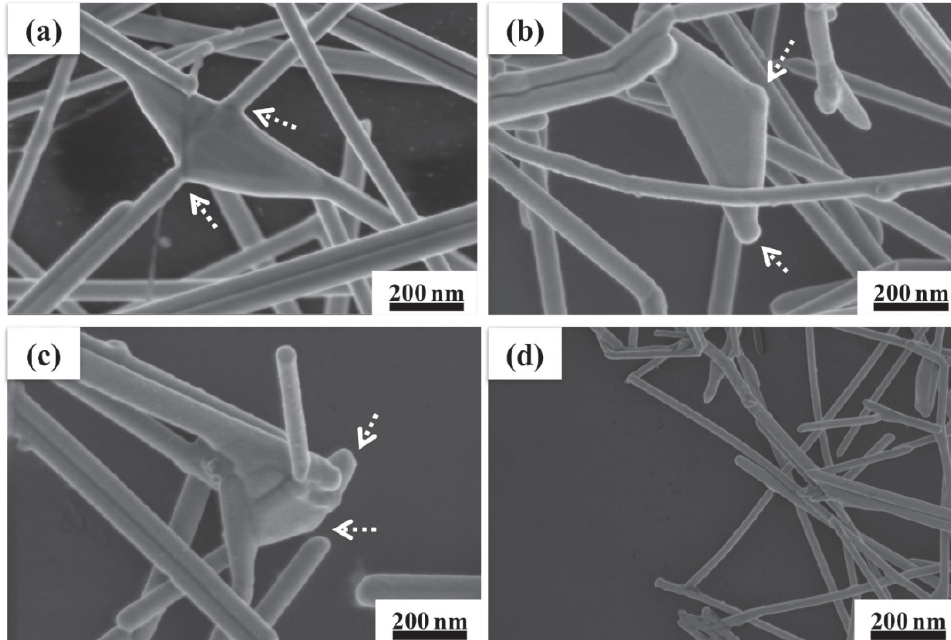
Figure 5. SEM images of annealed silver nanowire networks ( a ) before bending, ( b ) after imposing 10,000 bending cycles, and ( c , d ) after 500,000 bending cycles, high magnification and low magnifi- cation, respectively. Reproduced with permission from ref. [28]. Copyright 2014, Wiley.